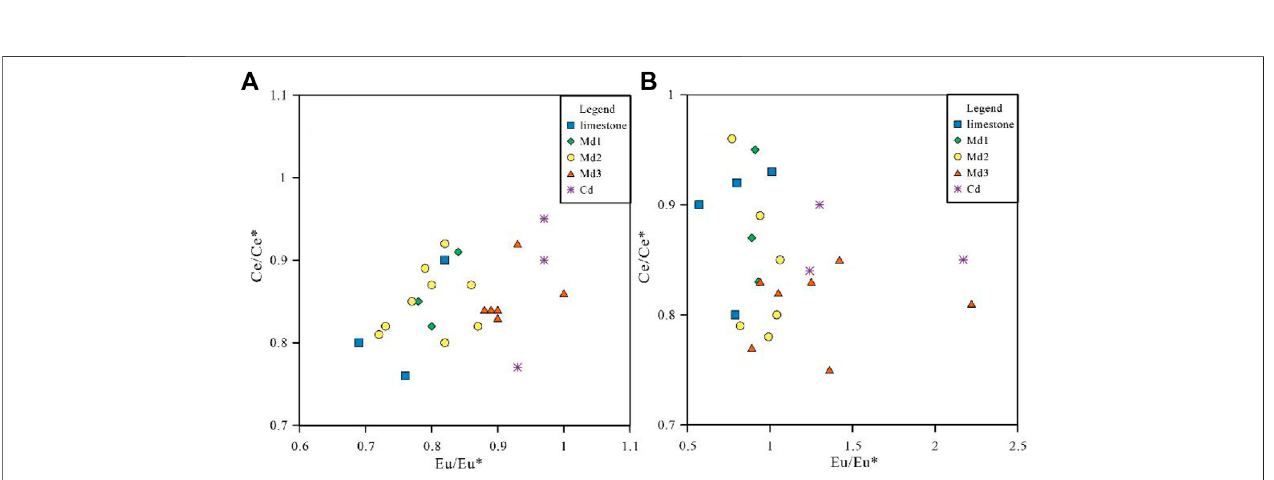
FIGURE 9 | Cross-plot of Eu/Eu* versus Ce/Ce* ratios in limestones and four types of dolomites. (A) Northwestern (NW) study area; (B) southwestern (SW) study area.